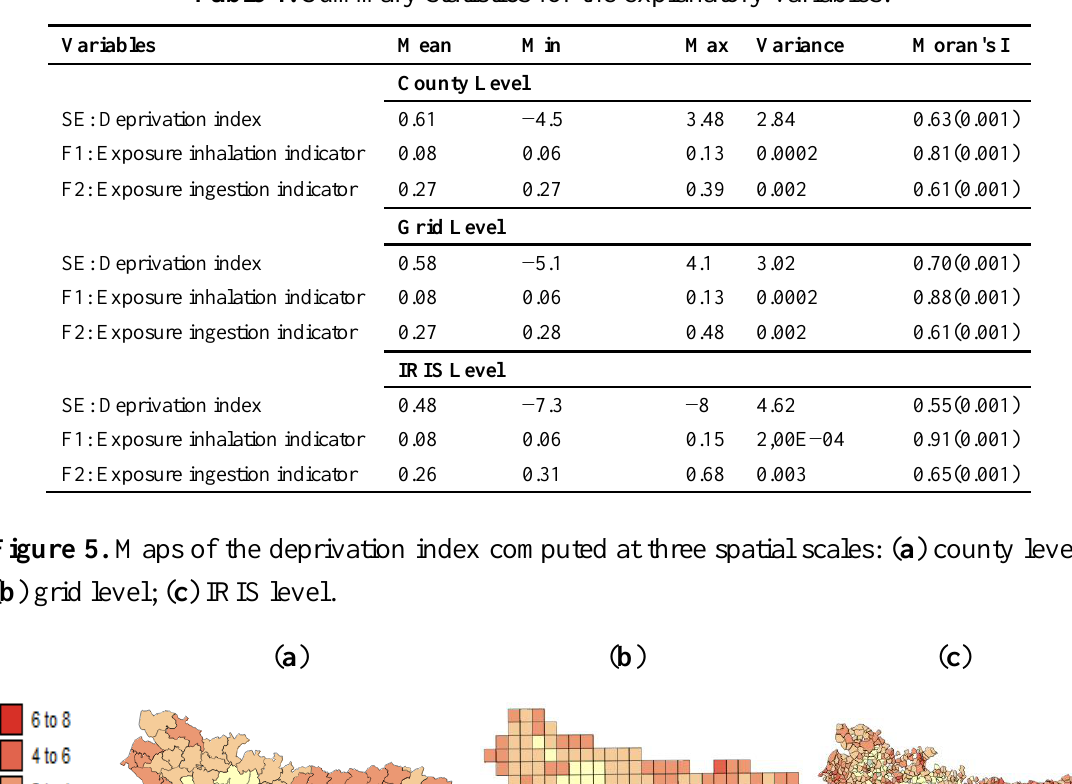
Table 4. Summary statistics for the explanatory variables.